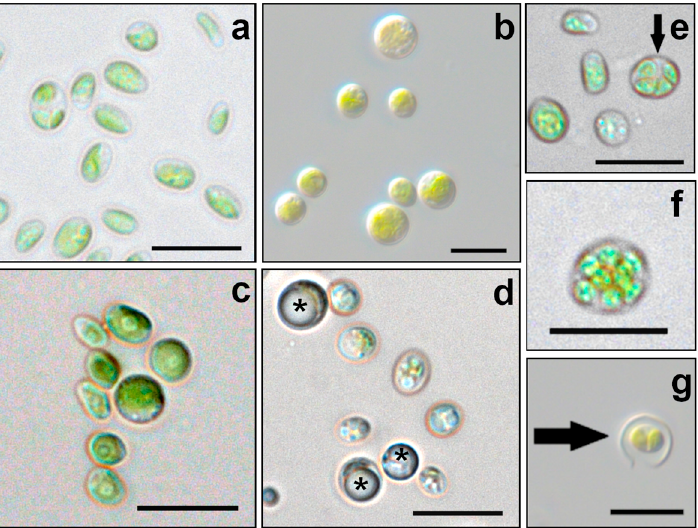
Figure 1. Cell morphology of Neochlorella semenenkoi IPPAS C-1210. Intensively growing three-day-old culture in liquid BG-11 medium ( a ); twenty-day-old culture grown on BG-11 plates ( b ); five-day-old ( c ) and six-month-old ( d ) cultures grown in liquid TAP medium; and cells with four ( e ), eight ( f ) and two autospores ( g ). The arrows indicate parent cell envelopes, and the asterisks indicate lipid droplets. Scale bars: 10 µm.